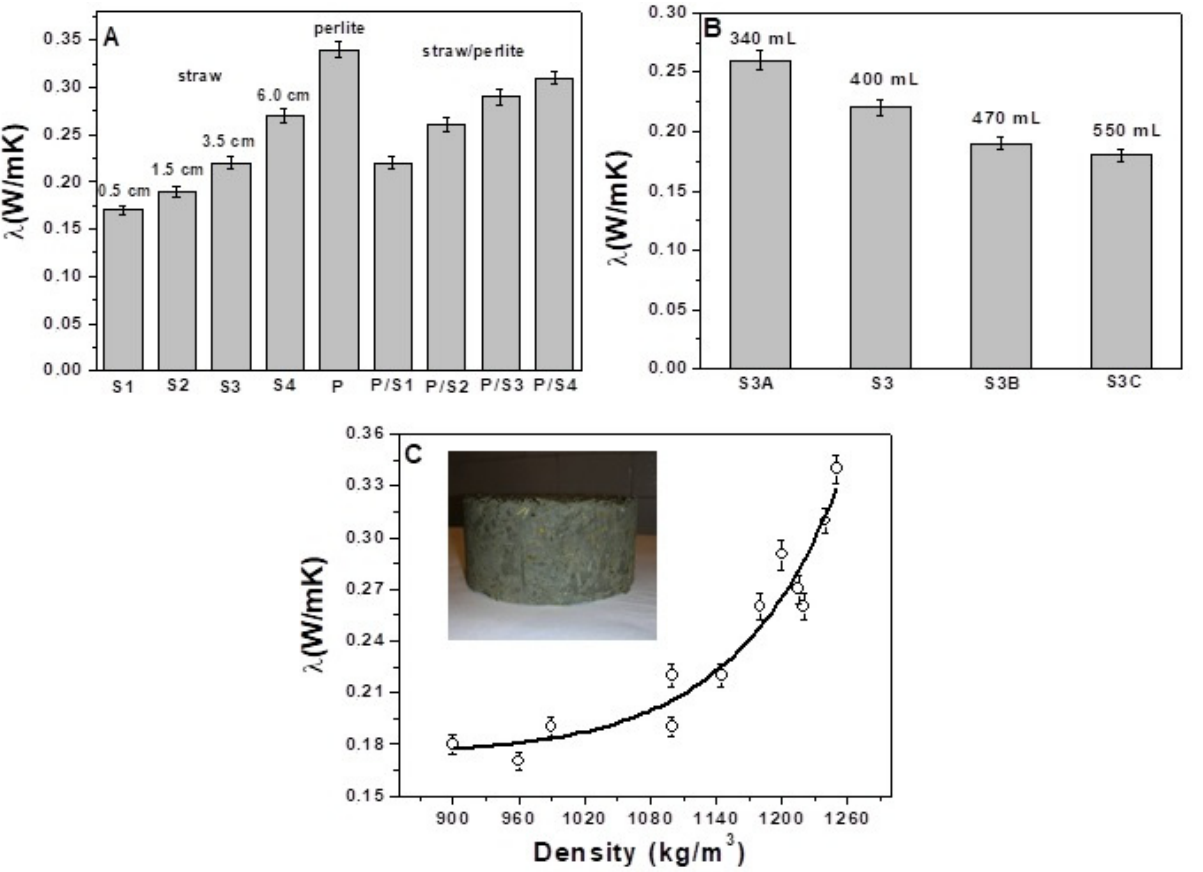
Figure 4. ( A ) Thermal conductivity of the specimens with the same volume of aggregates (400 mL). ( B ) Thermal conductivity of the S3 specimens with different volume of aggregates. ( C ) Exponential increase in the thermal conductivity with density increase. In the inset: image of a sample for thermal detections.